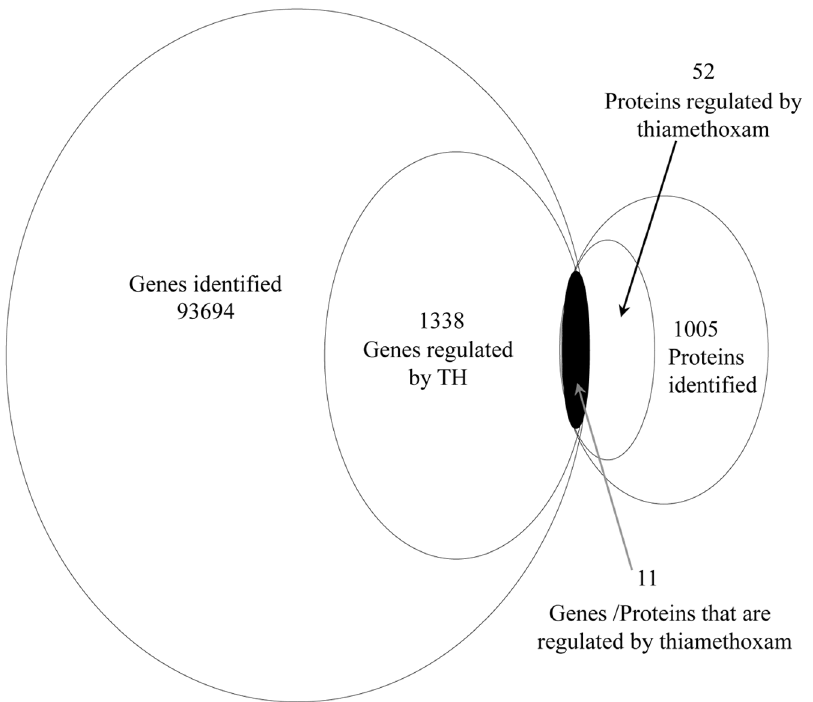
Figure 3. Correlation between the differently expressed proteins and genes. Scatter plots illustrates the distribution of differentially expressed proteins and related genes. The Pearson correlation coefficient between proteins and mRNA expression profiles is shown in the upper left corner of the plot.